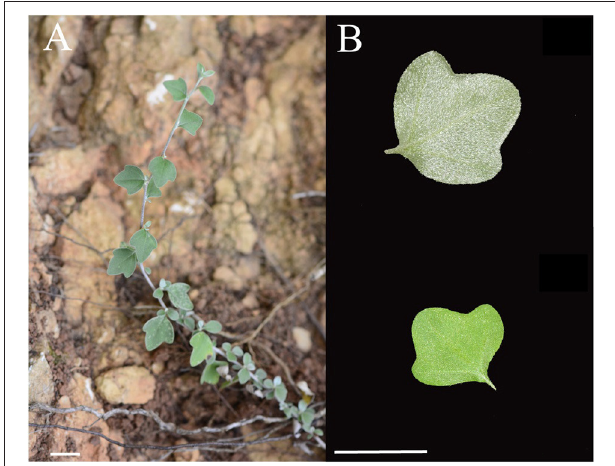
FIGURE 1 | The plant of C. rhombifolium . (A) The habitat; (B) leaf, up, abaxially, down, adaxially. Scale bars =